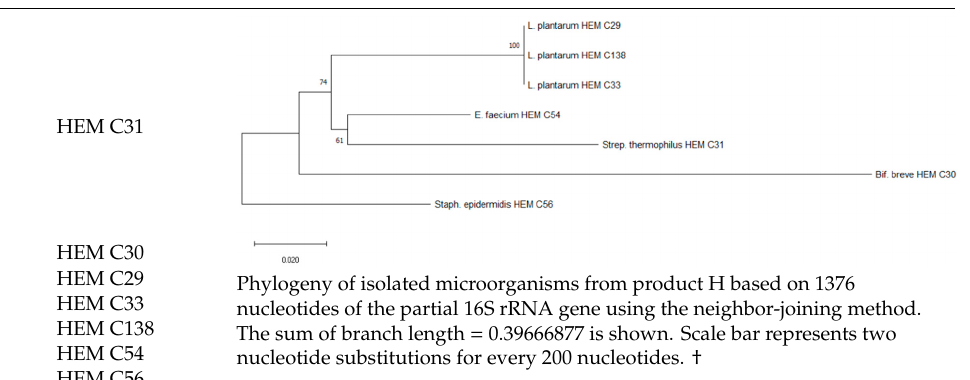
Phylogeny of isolated microorganisms from product G based on 1390 nucleotides of the partial 16S rRNA gene using the neighbor-joining method. The sum of branch length = 0.26710396 is shown. Scale bar represents two nucleotide substitutions for every 200 nucleotides. †